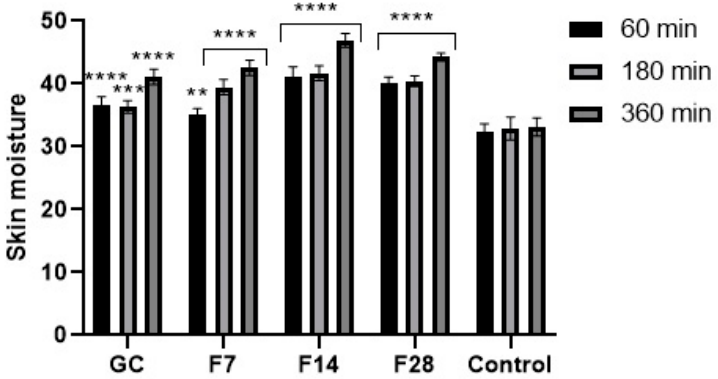
Figure 14. Influence of coffee beans and kombucha ferments on skin hydration. Data are the mean ± SD of five independent measurements. **** p < 0.0001, *** p < 0.0003, ** p < 0.03.